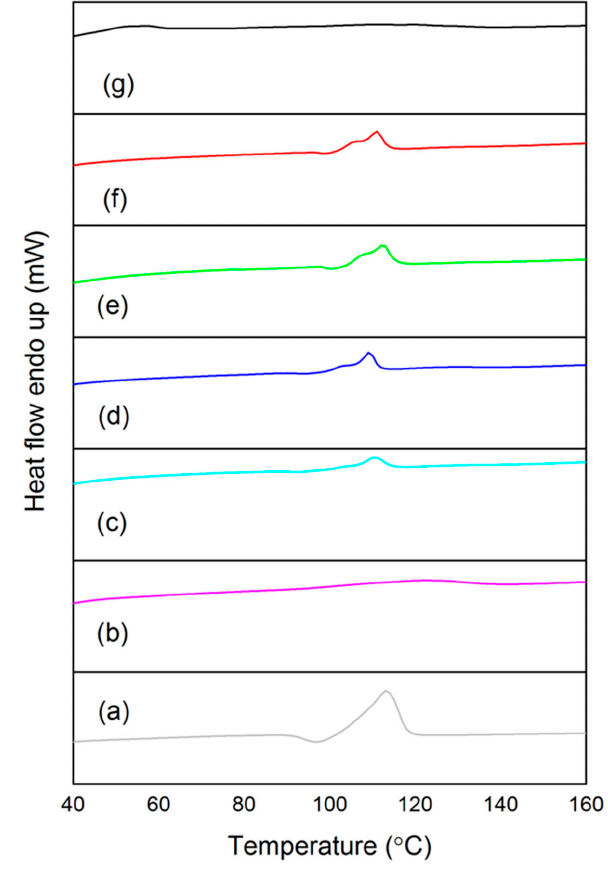
Figure 4. Second-heating Differential Scanning Calorimetry curves of ( a ) PBS, ( b ) PBAT, ( c ) TPRH48/12, ( d ) TPS48/12, ( e ) TPRH36/24, ( f ) TPS36/24, and ( g ) commercial PBAT.